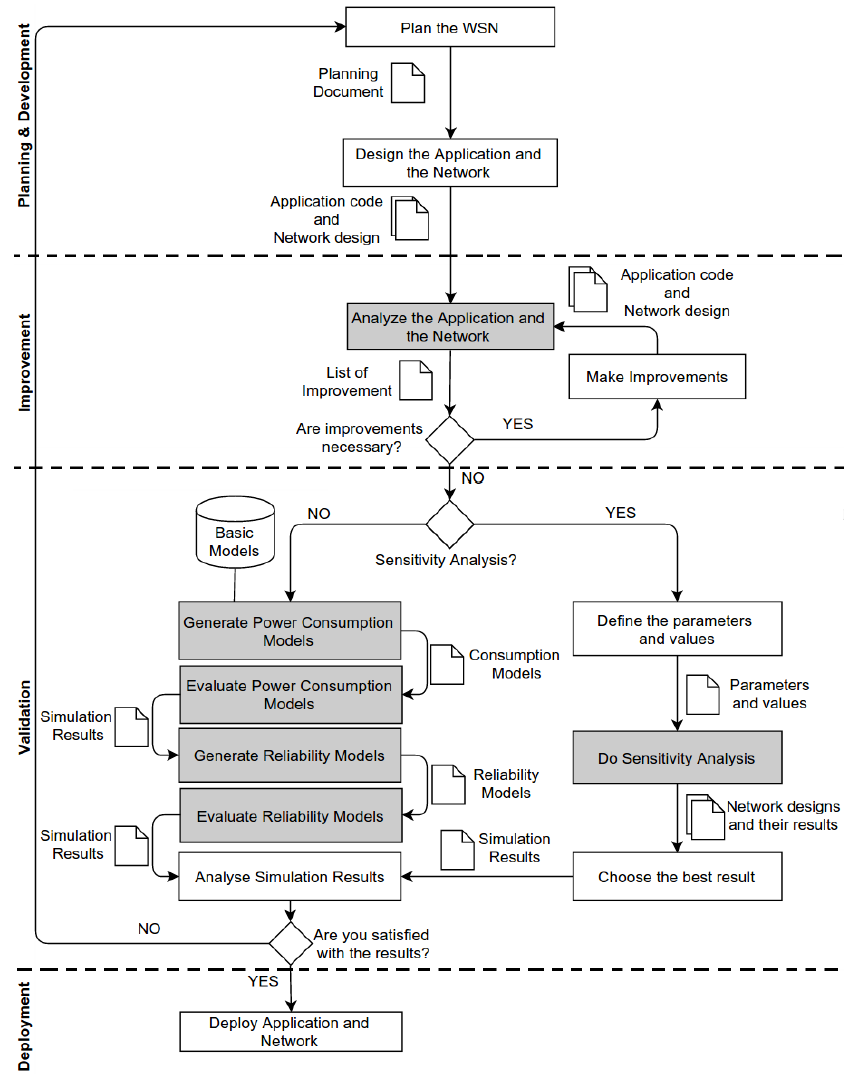
Figure 3. Proposed